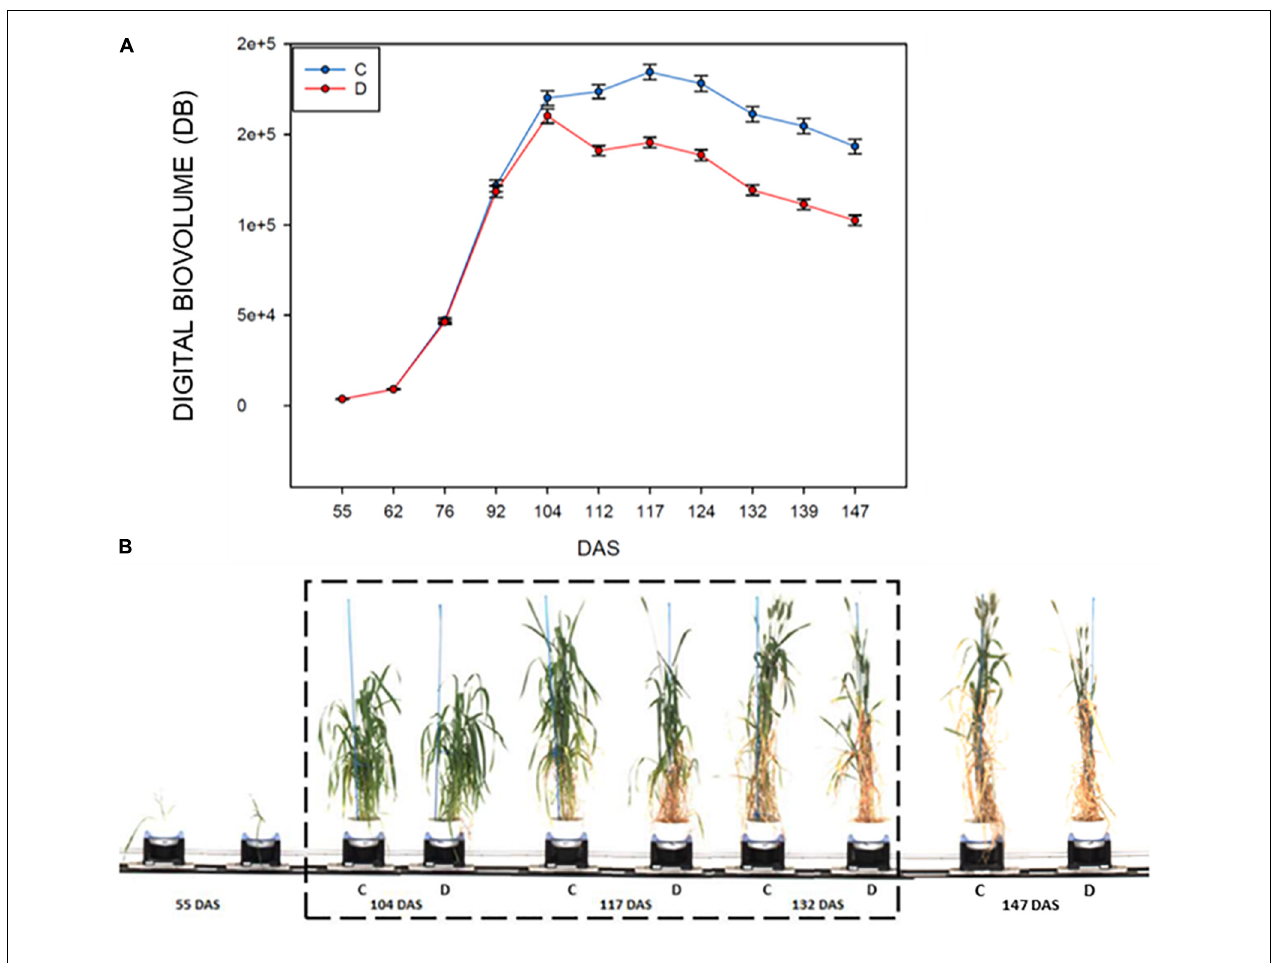
FIGURE 2 | RGB HTP analyses for control and drought-stressed plants in the period 55–147 DAS, measured using a Lemnatec Scanalyzer 3D. (A) Mean value of the Digital biovolume (DB): C, control plant; D, drought stressed plants. (B) Example of the acquired RGB Images of a representative durum wheat genotype, showing the effects of drought stress on plant growth. The drought stress interval is indicated with dashed box.